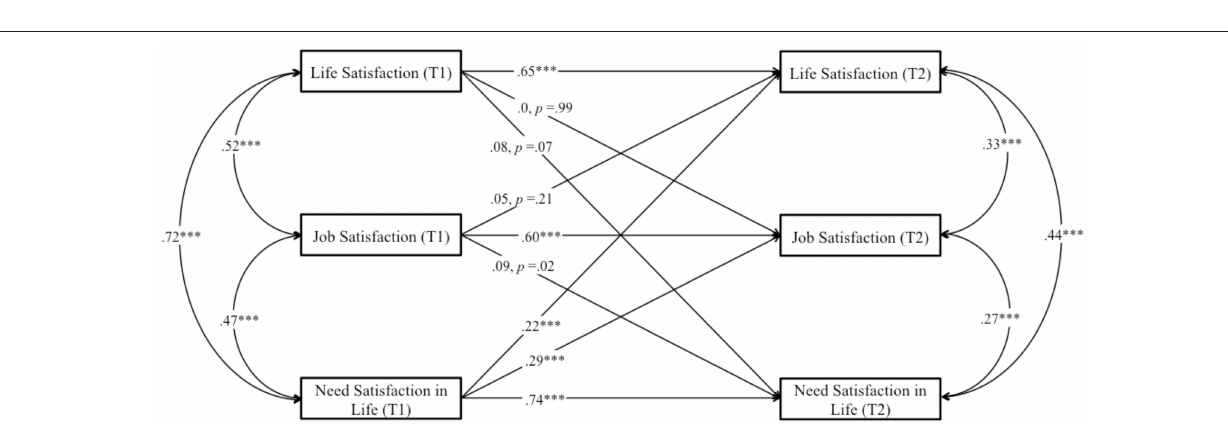
FIGURE 6 | Study 3. Structural longitudinal model for the association between job satisfaction and life satisfaction, and need satisfaction at life. Coefficients shown are standardized paths. Error terms are not shown to enhance visual clarity. Tl, Time 1; T2, Time 2. *** p <